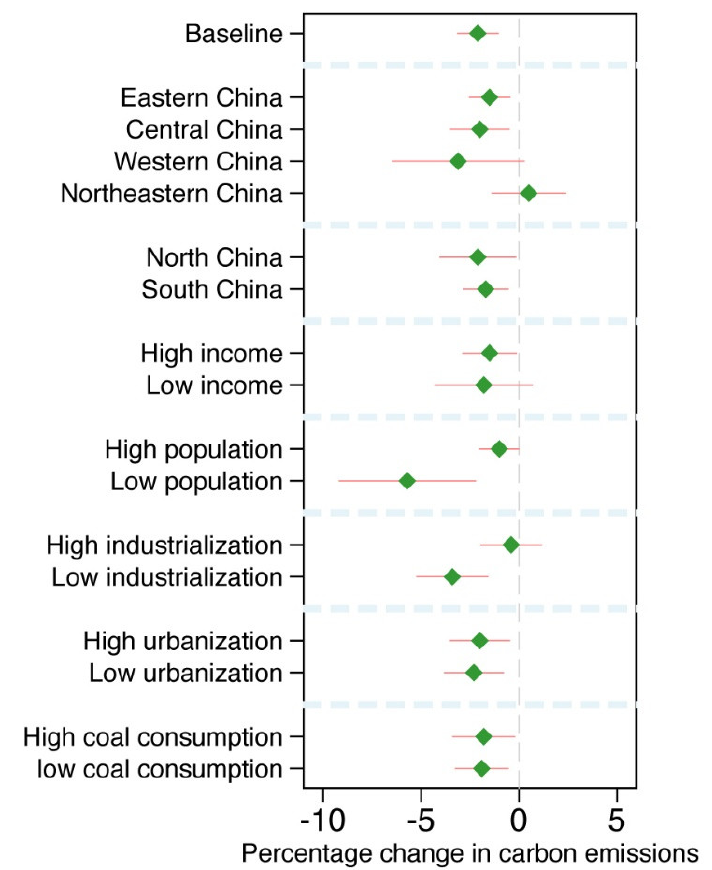
Figure 3. Heterogeneity analysis.